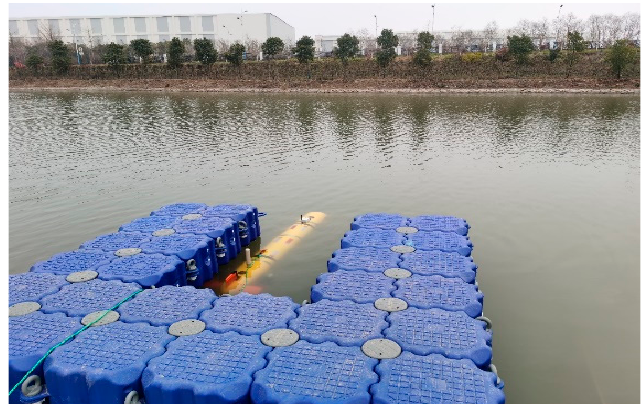
Figure 27. AUV path planned for the field test.